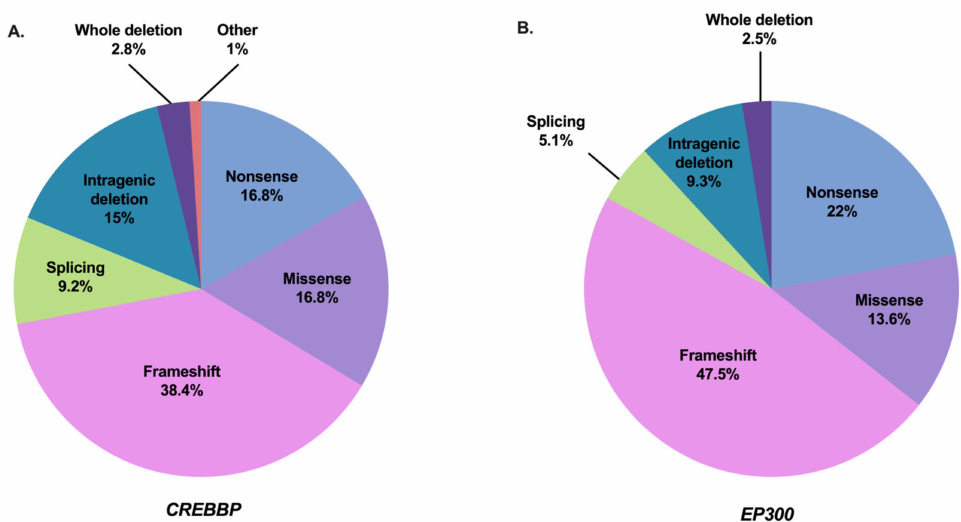
Figure 2. Mutation spectrum of CREBBP and EP300 in RSTS individuals referenced in the literature and HGMDPro variant or LOVD databases [100,101]. ( A ) Repartition of all 500 pathogenic variants in CREBBP gene referenced as causing RSTS1 including 84 nonsense mutations, 192 frameshift mutations, 46 splicing mutations, 84 missense mutations, 75 intragenic deletions, 14 deletions including the entire CREBBP gene, and 5 other abnormalities (2 intragenic duplications and 3 complex rearrangements). ( B ) Repartition of all 118 pathogenic variants in EP300 gene referenced as causing RSTS2 including 26 nonsense mutations, 56 frameshift mutations, 6 splicing mutations, 16 missense mutations, 11 intragenic deletions, and 3 deletions encompassing the entire EP300